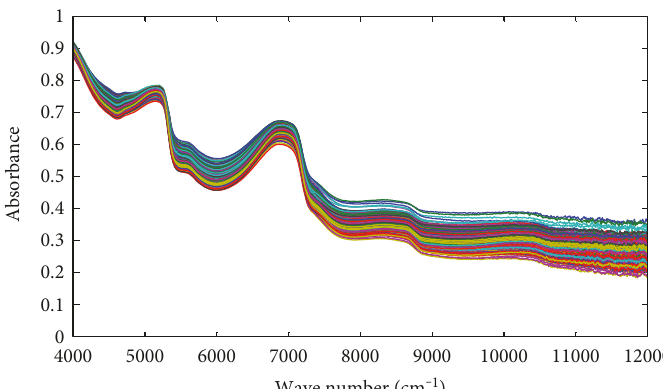
Figure 1: Near-infrared spectra of wheat leaves during the incubation period of wheat stripe